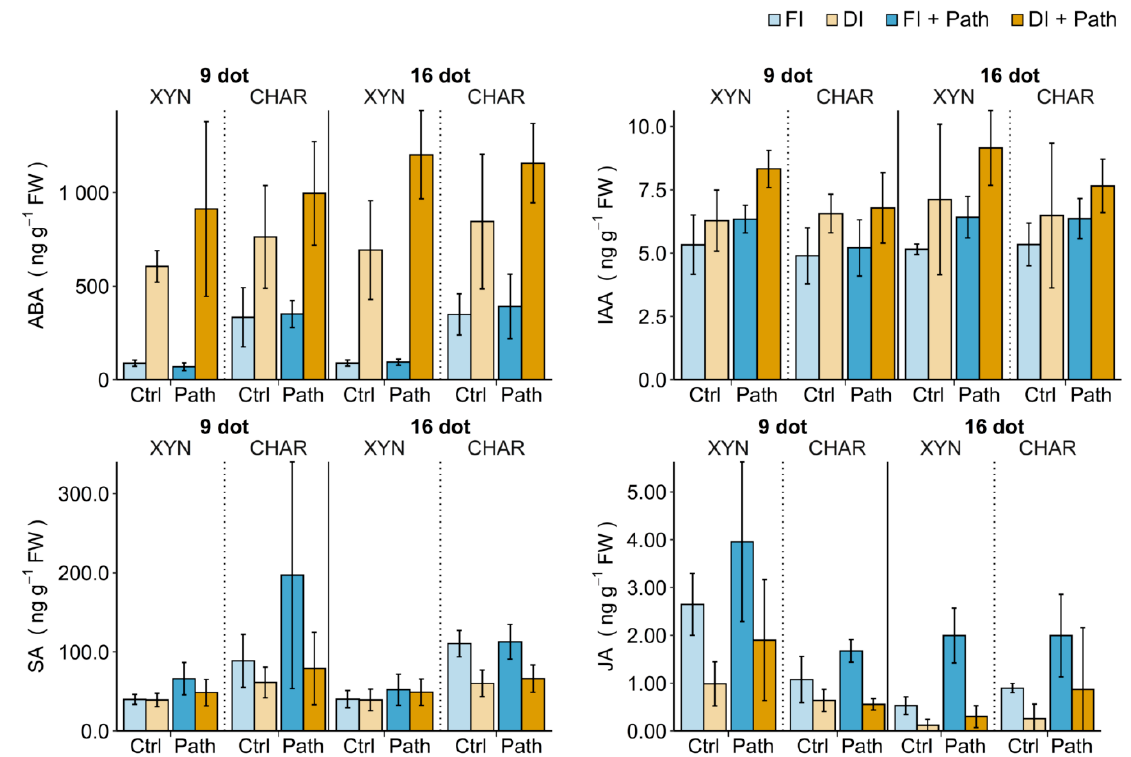
Figure 5. The impact of drought and pathogen stress on the leaf phytohormone balance. Xynisteri (XYN) and Chardonnay (CHAR) plants were subjected to 7 or 14 days of full (FI) or deficit (DI) irrigation before in planta inoculation with water (Ctrl) or P. viticola (Path) (continued exposure to full/deficit irrigation; see Figure 1). Samples for analysis were taken at 1.5 days post inoculation (dpi), corresponding to 9 or 16 days of irrigation treatment (dot). Each treatment consisted of five repetitions. For the effect of drought stress, the fully irrigated and deficit-irrigated control plants should be compared. For the effect of pathogen stress, water-inoculated and pathogen-inoculated fully irrigated plants should be compared. The bars and error bars show the mean and the standard deviation, respectively. Abbreviations: see Table 1.